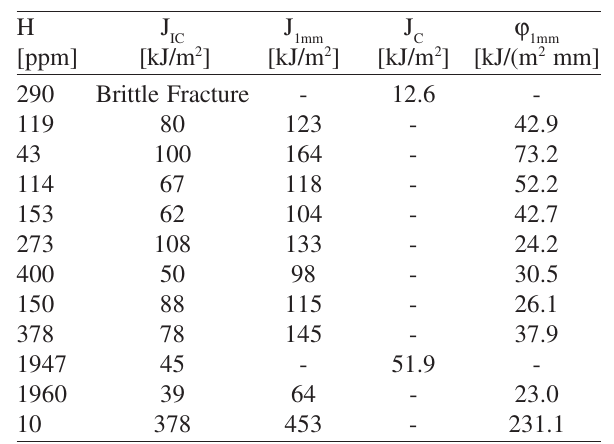
, J , J and ϕ values obtained at different IC 1mm C 1mm